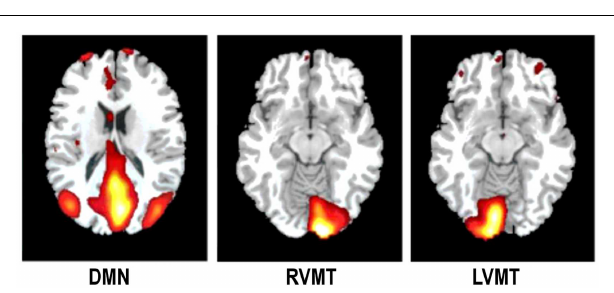
FIGURE 1 |The experimental design framework. In this structure it is possible to identify two main phases (or steps).The first step is to identify what to monitor, i.e., performing a Functional Localization.This can be done